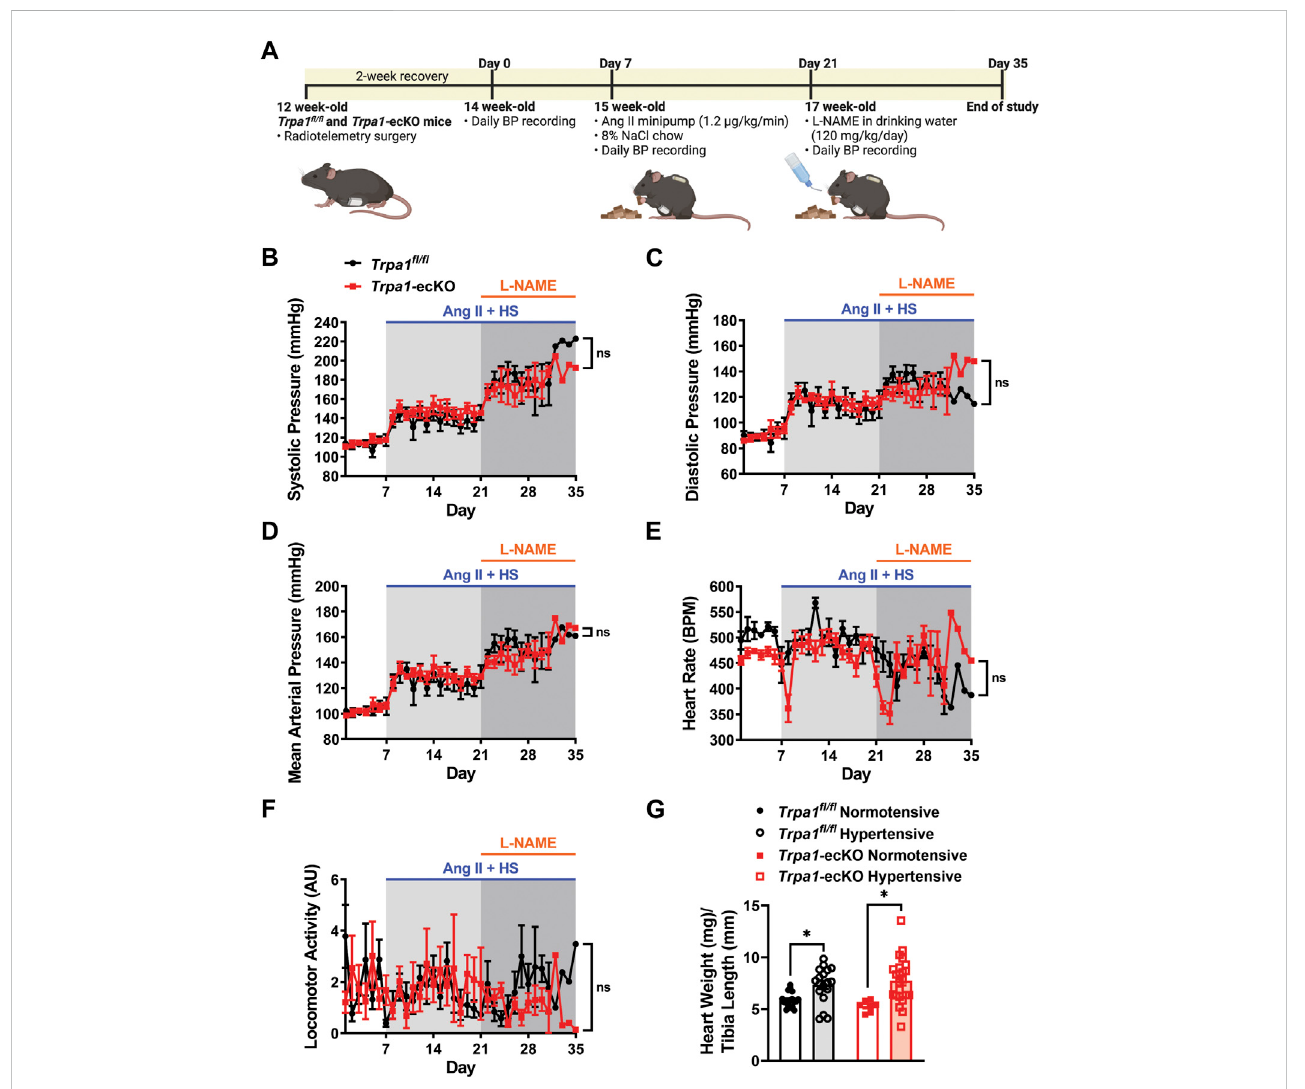
FIGURE 1 Endothelial cell Trpa1 knockout does not affect resting BP or responses to hypertensive stimuli. (A) Schematic representation of the hypertension protocol. 12-week-old Trpa1 fl / fl (control) and Trpa1 -ecKO mice were surgically implanted with radiotelemetry probes to measure blood pressure (BP). Followinga2-weekrecovery,baselineBPwasrecordedfor7 days.ThesemicewerethenimplantedwithsubcutaneousAngIIminipumps(1.2 μ g/kg/min)and fed an 8% high-salt (HS) diet. After 2 weeks, the drinking water was supplemented with the NOS inhibitor L-NAME and treatment was continued for another 2 weeks. (B – F) Systolic BP (B) , diastolic BP (C) , mean arterial pressure (D) , heart rate (E) , and locomotor activity (F) were recorded from control and Trpa1 -ecKO mice before and after Ang II/HS/L-NAME treatment (n = 8 for control, n = 6 for Trpa1 -ecKO, two-way ANOVA, ns = not signi fi cant). (G) Heart weight normalized to tibia length was assessed from normotensive and hypertensive control and Trpa1 -ecKO mice (n = 18 for normotensive control, n = 18 for hypertensive control, n = 7 for normotensive Trpa1 -ecKO, n = 23 for hypertensive Trpa1 -ecKO; two-way ANOVA, * p <